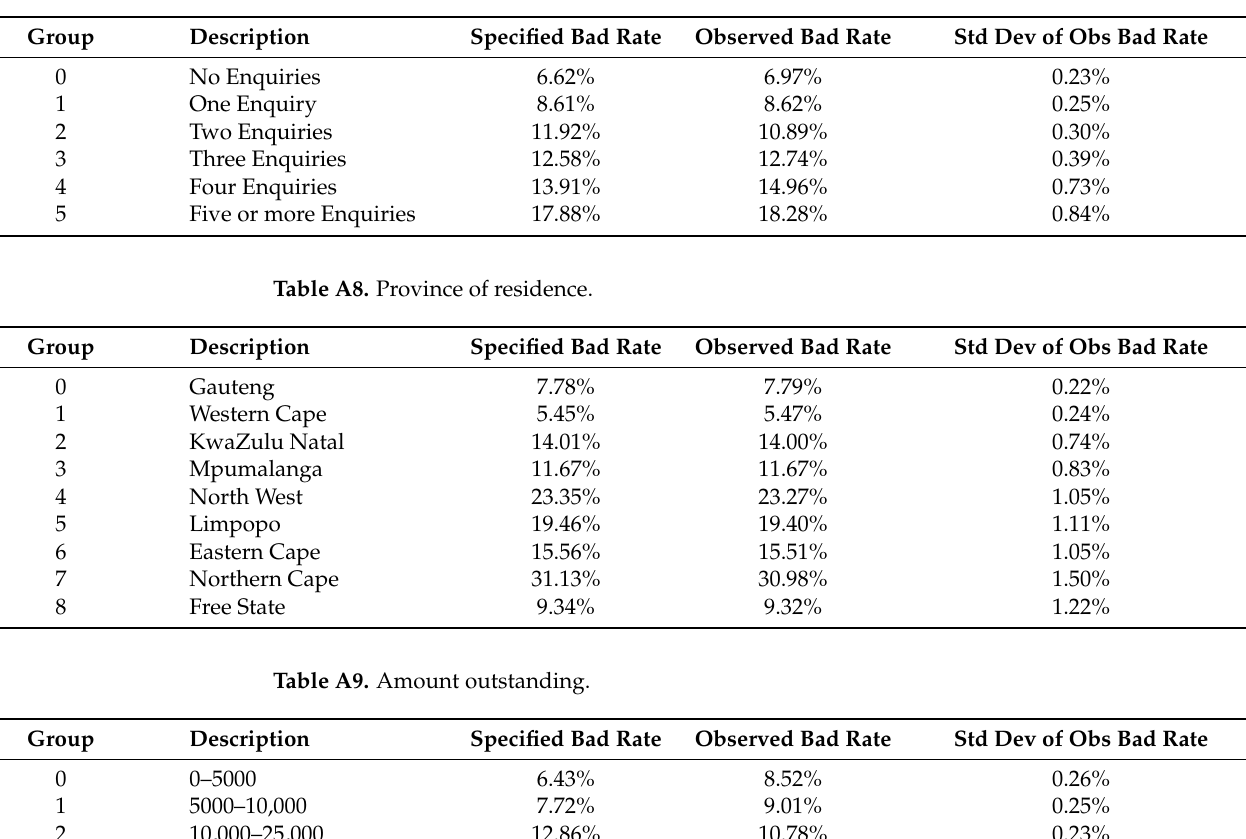
Table A7. Number of enquiries.